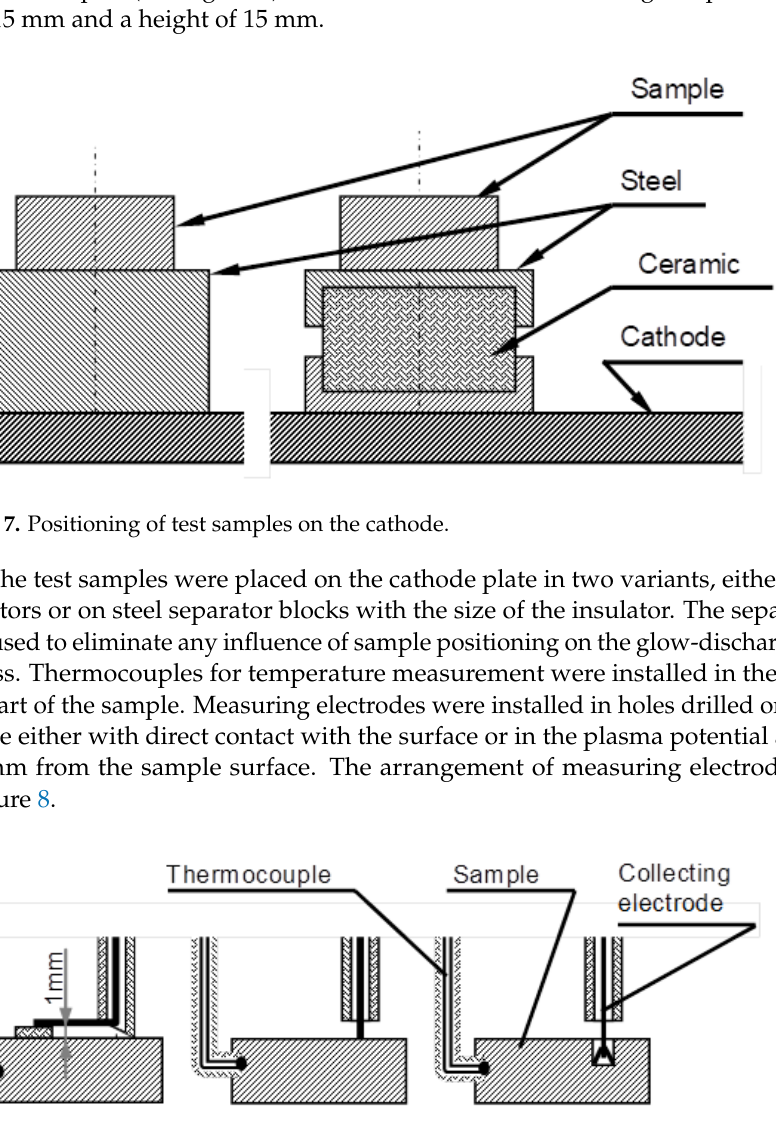
Figure 8. Arrangement of measuring electrodes relative to the sample